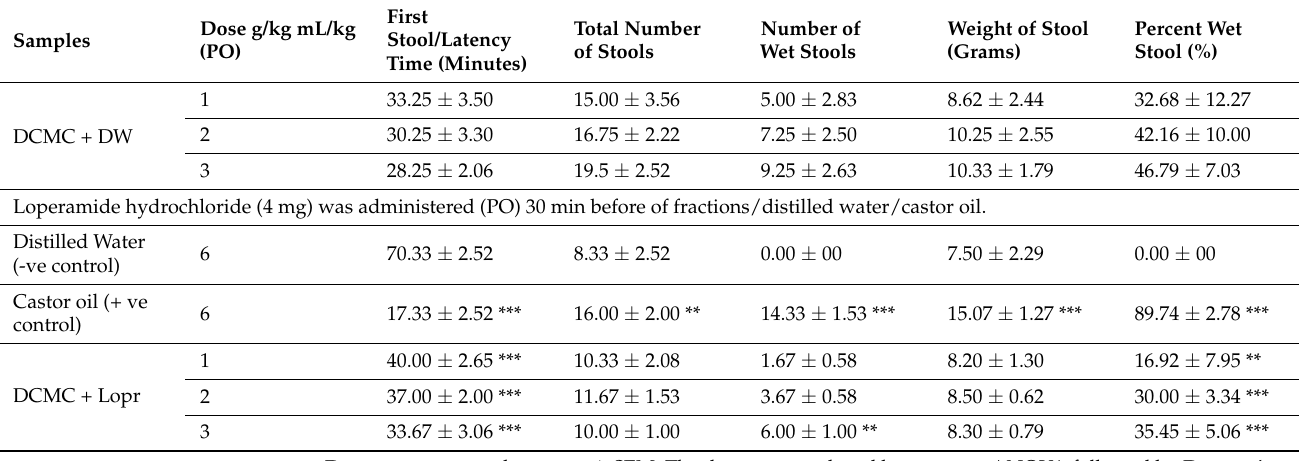
Table 8. Diarrheal/laxative activity of